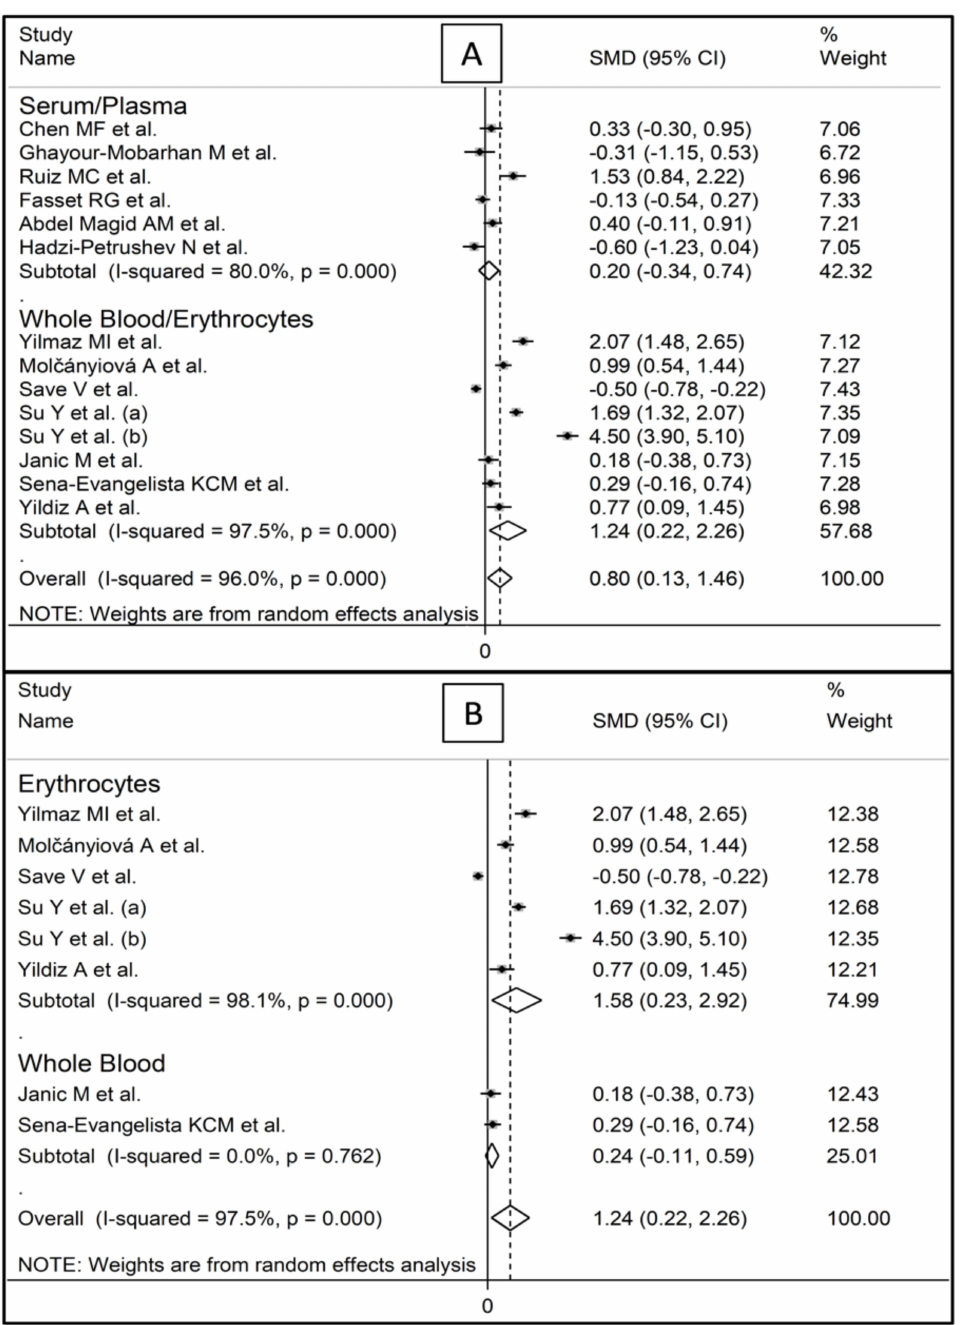
Figure 4. Forest plot of studies investigating GPx concentrations according to biological matrix: ( A ) whole blood/erythrocytes vs. plasma/serum; ( B ) whole blood vs.